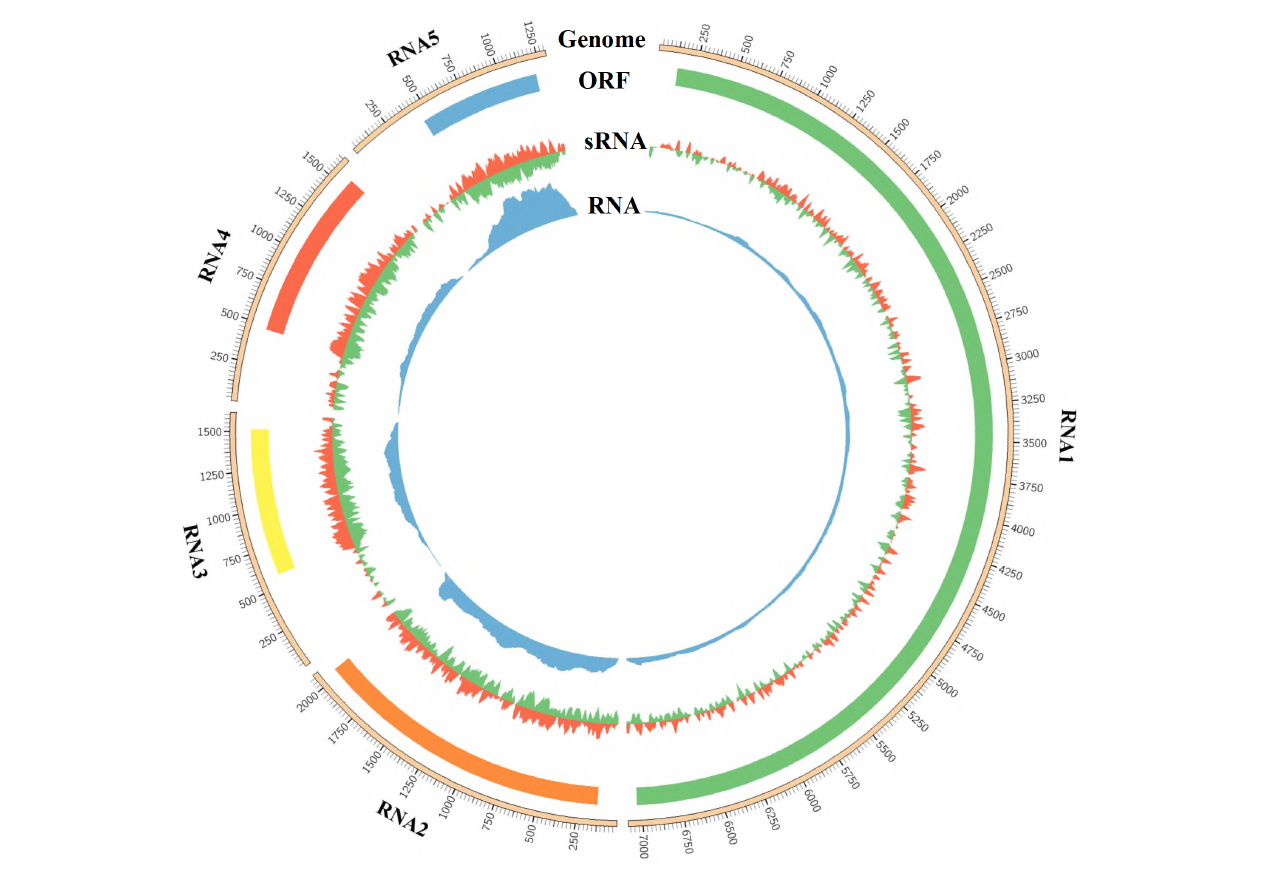
FIGURE 3 | Profile distribution of reads from sRNA-seq and RNA-seq libraries along RNA1 to RNA5 of grapevine emaravirus A (GEVA). Outer ring represents the genome of RNA1, RNA2, RNA3, RNA4, and RNA5 segments of GEVA; the open reading frame (ORF) in each RNA segment is shown below the genome graphic and above the depth of sRNA reads and RNA